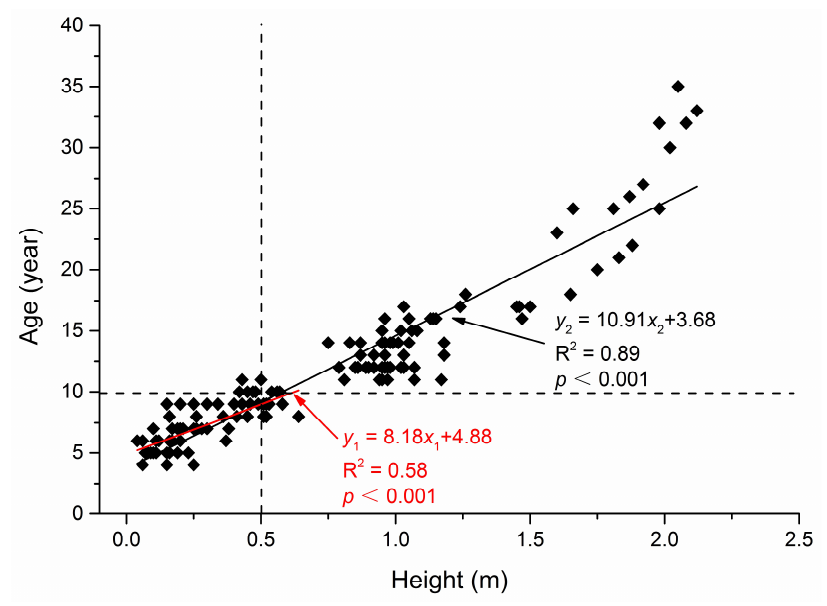
Figure A2. Relationship between the age and height of Abies faxoniana in forest gaps in a subalpine coniferous forest.